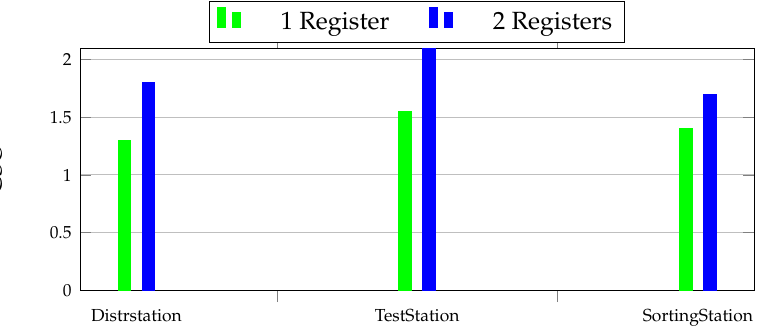
Figure 17. Measured code size